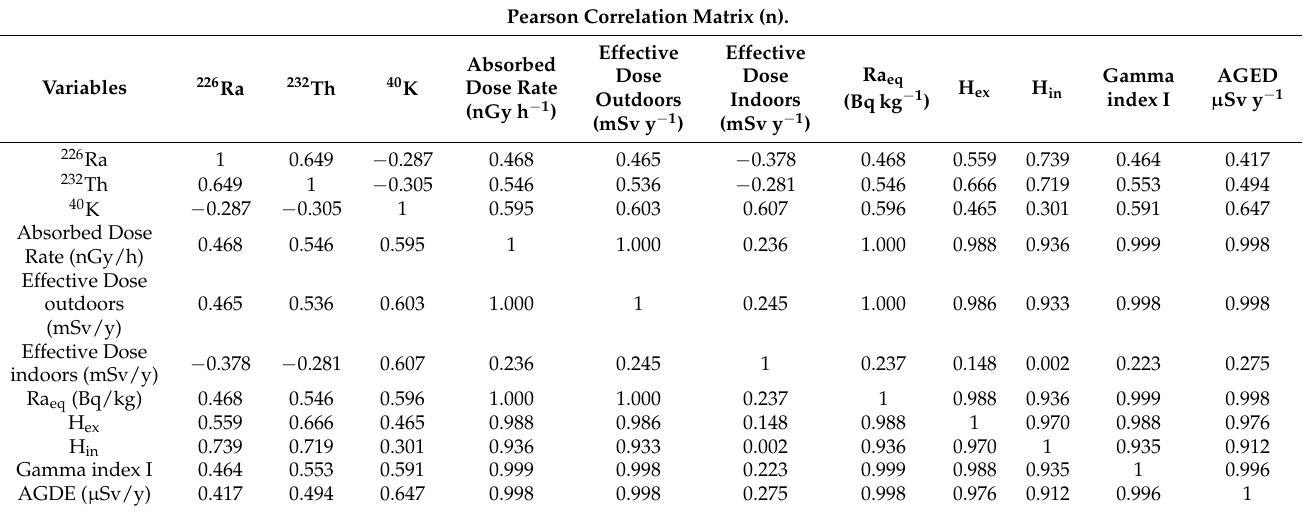
Table 4. Pearson correlation matrix among the considered variables. Pearson Correlation Matrix